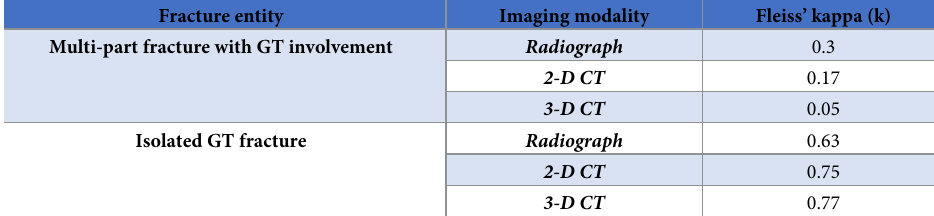
Table 1. Interobserver reliability assessed with Fleiss’ kappa